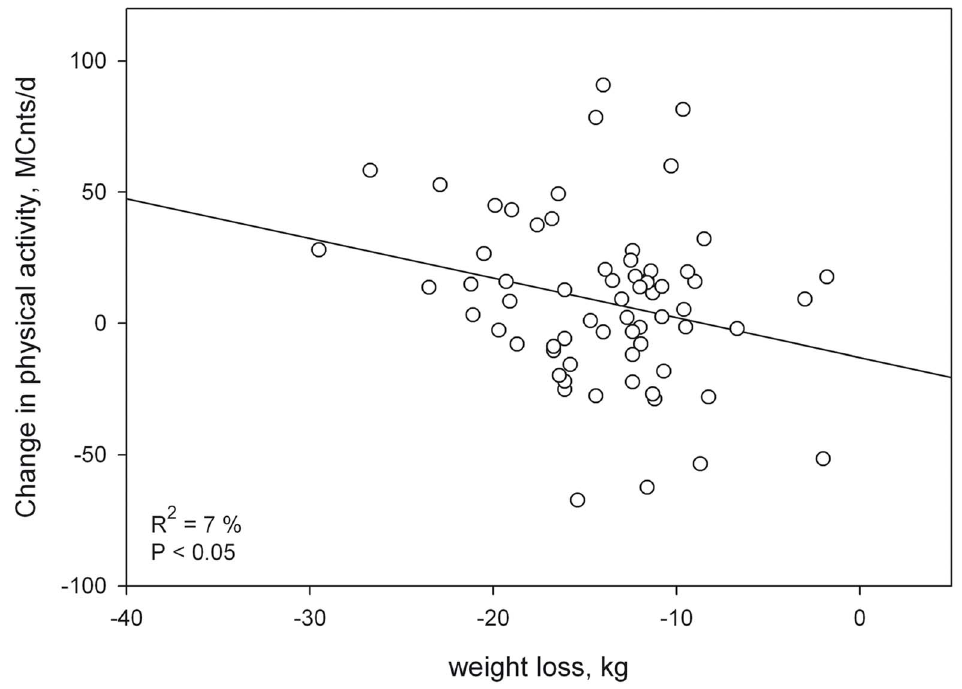
Figure 2. Association between the change in body movement and the change in body weight.